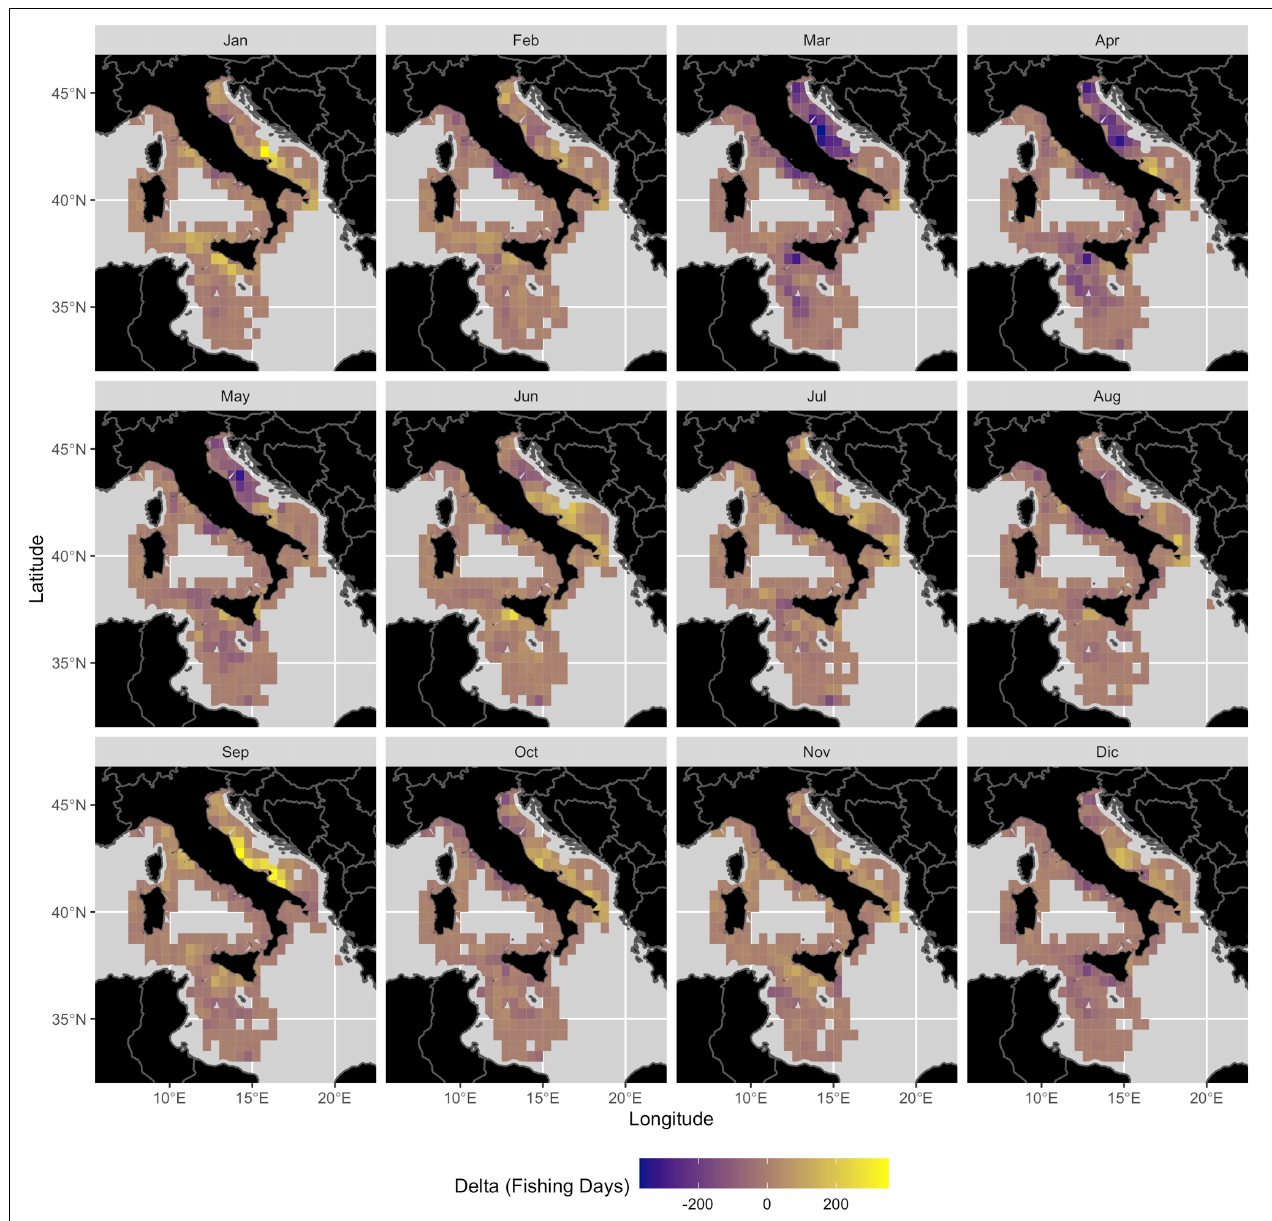
FIGURE 5 | Pattern of changes (difference in percentage between the value of Fishing Days in 2020 and the mean value during the years 2015–2019) over the-30 × 30 nautical miles grid established by the GFCM (https://www.fao.org/gfcm/data/maps/grid/en/).